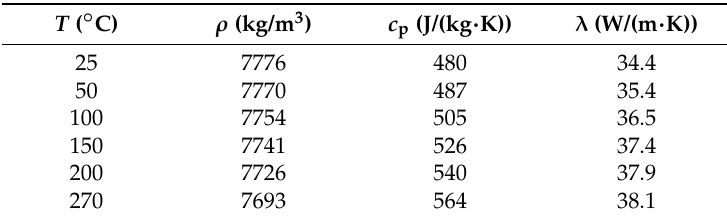
Table 2. Martensite physical properties.